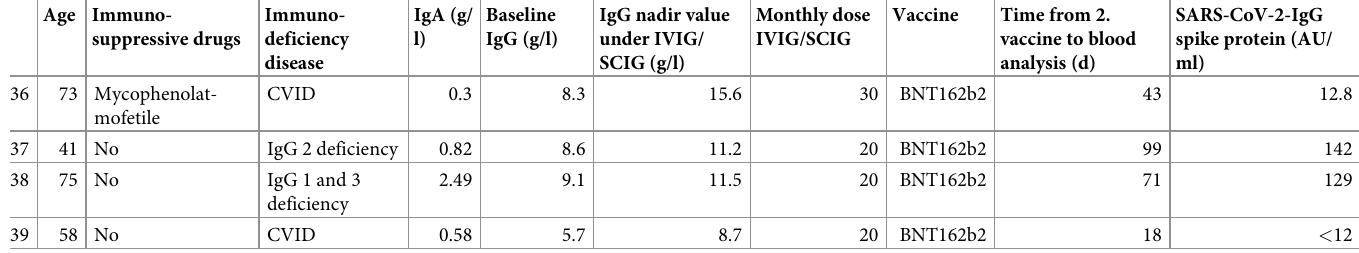
p = 0.002. All individuals with a humoral non-response to the vaccines (n = 13) were either under immunosuppressive drugs (including anti-CD20 therapy in the past) (7/13, 53.8%) and/ or had a diagnosis of CVID (10/13, 76.9%). Two patients treated by immunosuppressive treat- ment showed a low anti-S response (Fig 1). Median anti-S concentration in individuals with a